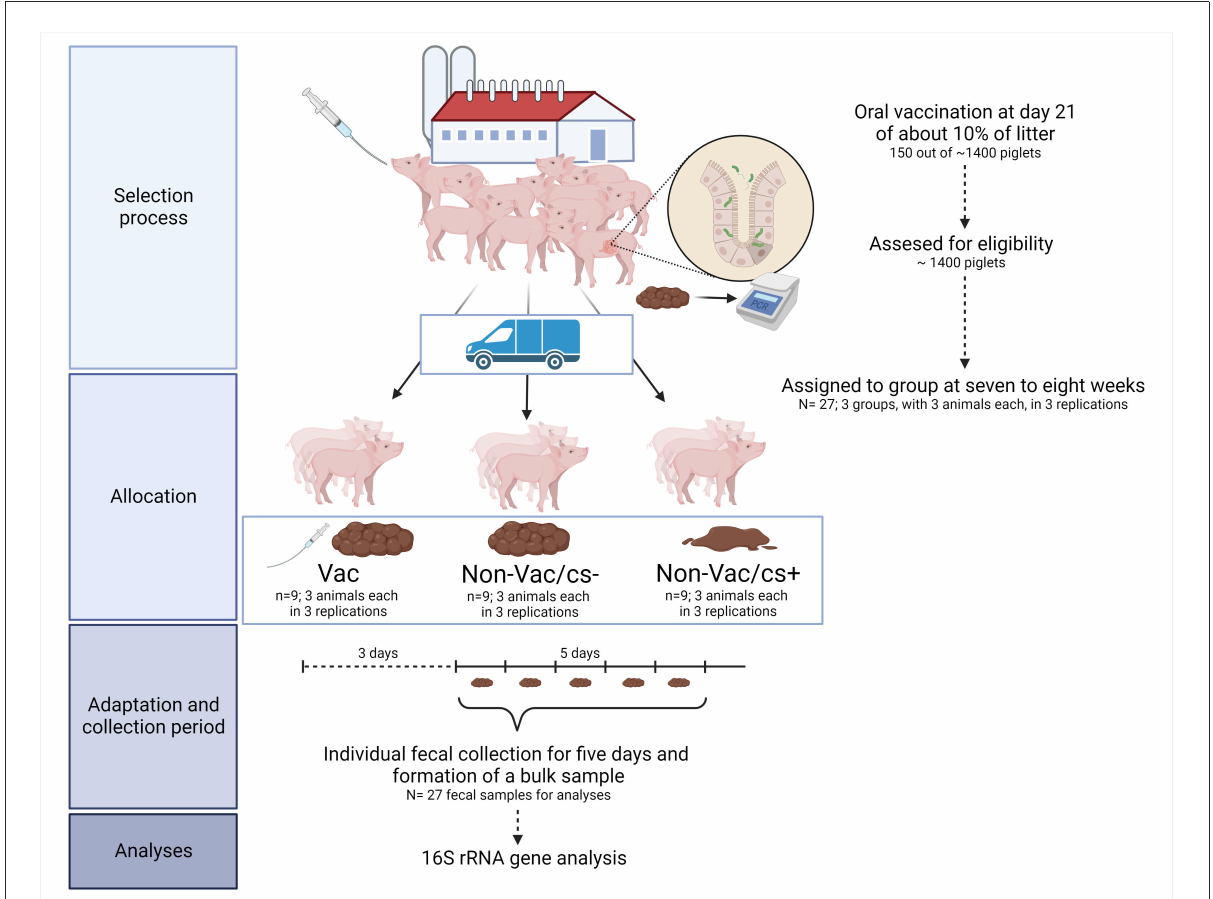
FIGURE1 Clinical trial flow diagram. The diagram indicates selection process, the trial set-up, the collection of samples, and the analyzed parameters. The figure was created with